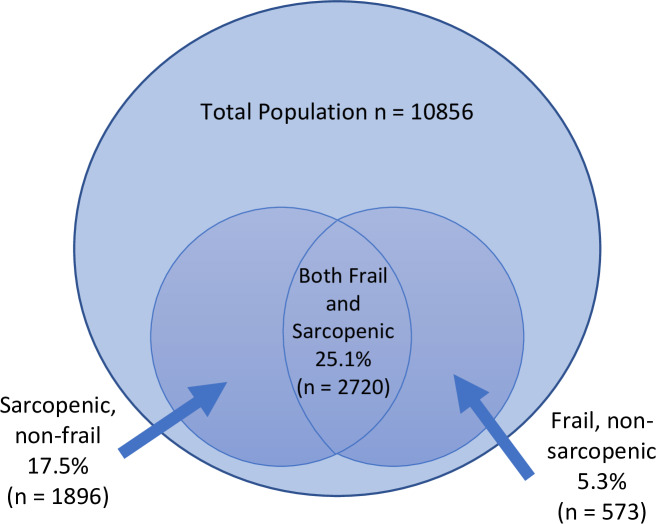
Overlap of frailty (FRAIL) and Sarcopenia (SARC-F).Most individuals who screened positive for frailty or sarcopenia concurrently screened positive for both geriatric syndromes, creating a large overlap between the two syndromes.